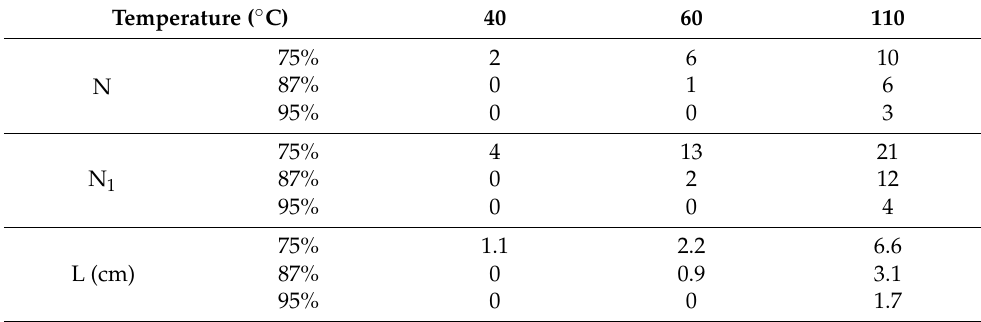
Table 2. The results of the CCC crack